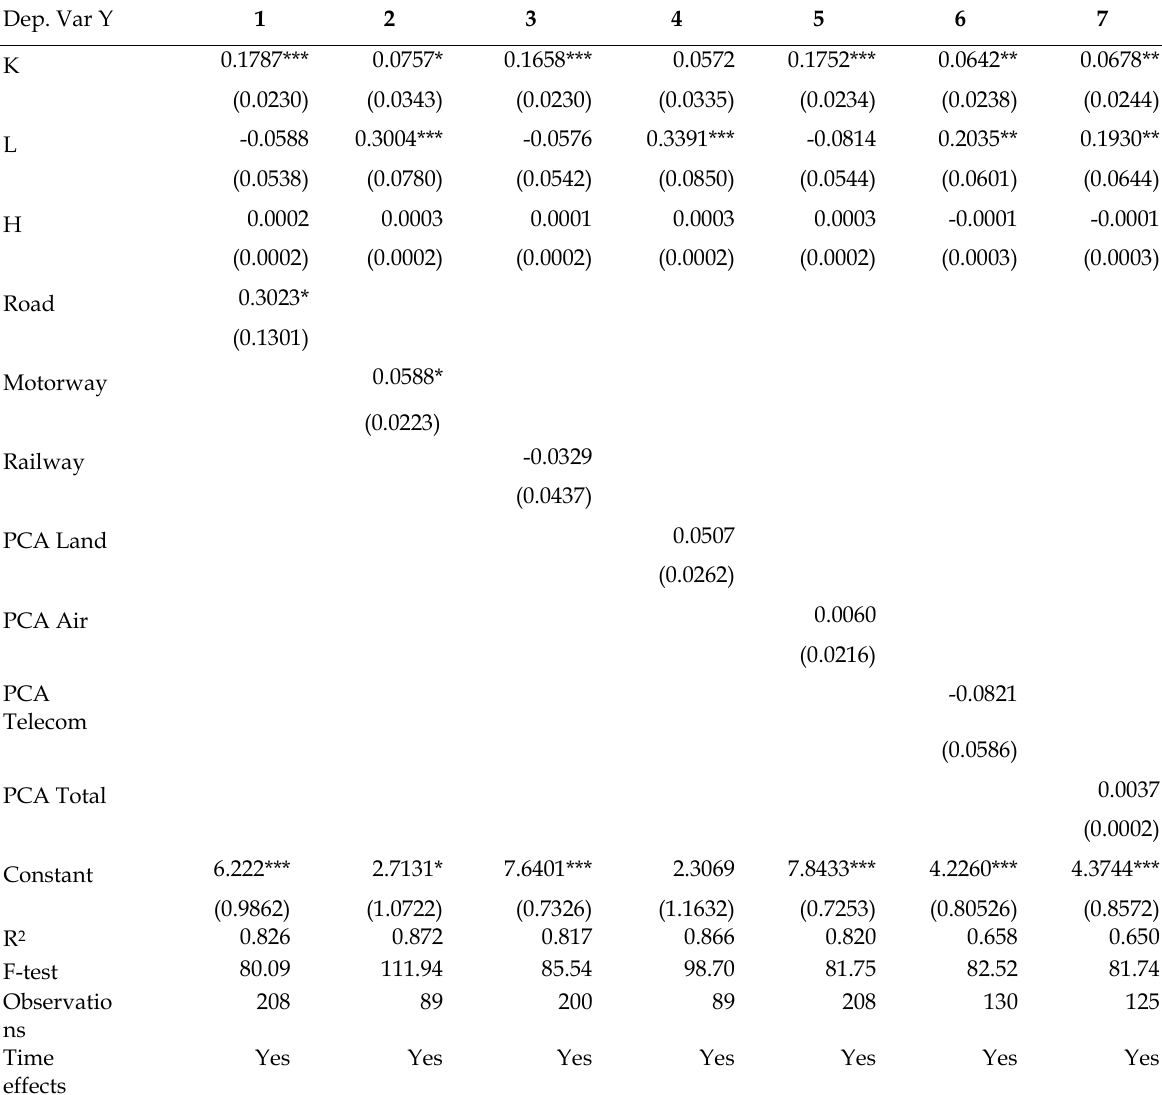
Table 5. Results of the fixed-effect estimation Dep. Var